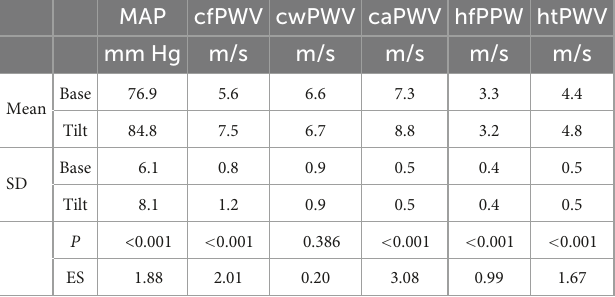
TABLE 2 Pulse-wave velocity response to the modified head-up tilt-table test responses [Data points = 81 (27 subjects × 3 time points)].